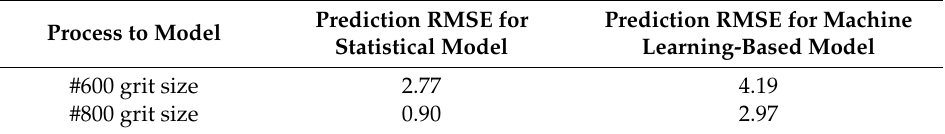
Table 6. The prediction RMS error values of developed process